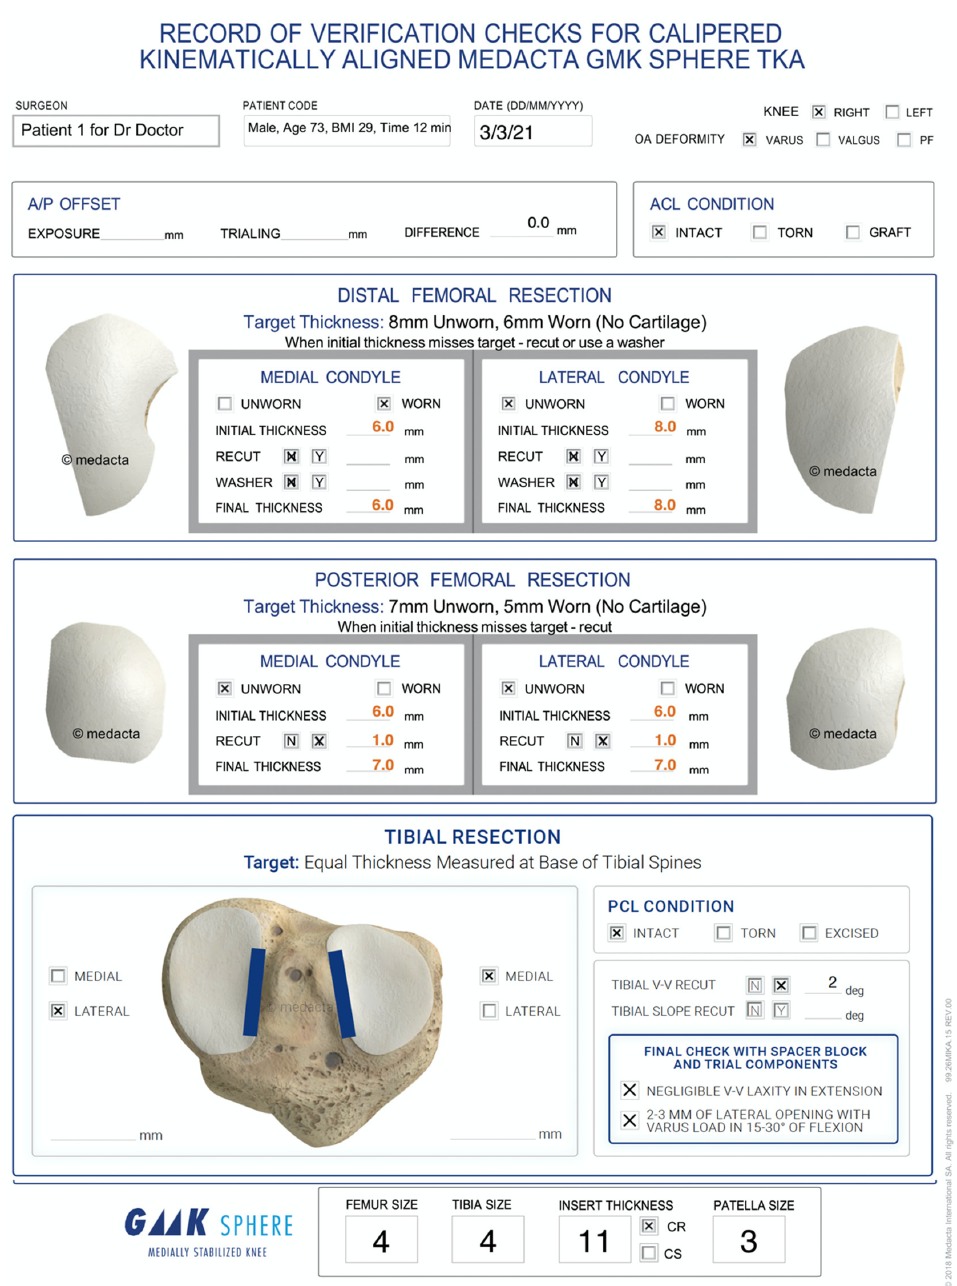
Figure 1. The image shows the intraoperative verification worksheet of a patient including entries for patient number, surgeon name, sex, age, BMI, time to complete corrected femoral cuts, date of surgery, right or left knee, type of primary deformity (varus, valgus, or patellofemoral), condition of ACL and PCL, target thickness of femoral resections, initial and corrected caliper-measured thickness of each femoral